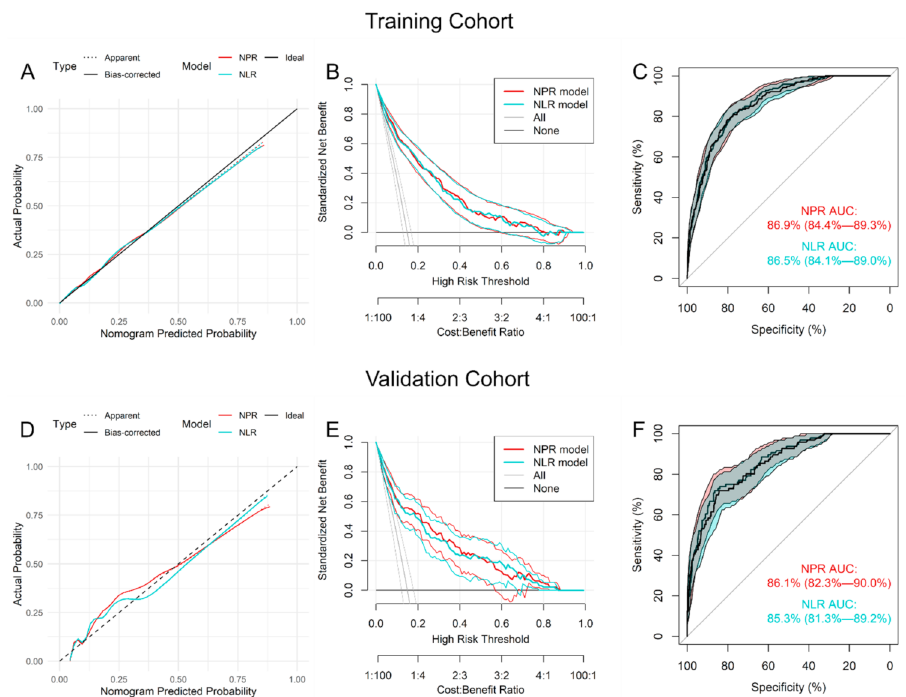
Figure 2. Evaluation of the prediction value of the nomograms NPR (red) and NLR (blue) in the training ( A–C ) and validation ( D–F ) cohorts. ( A , D ) Calibration plots (pointed lines represent the apparent calibration curves, solid lines represent the bias-corrected calibration curves obtained from the 1000 bootstrap and dashed line represent the ideal calibration curve), ( B , E ) decision curves and ( C , F ) ROC curves of the nomogram score. Abbreviations: NLR, neutrophil-lymphocyte ratio; NPR, neutrophil-platelets